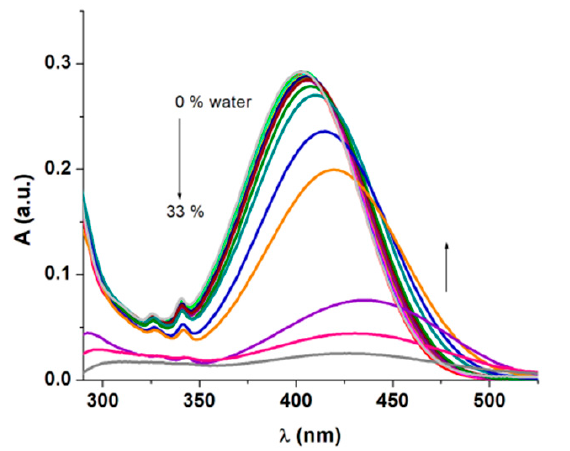
Figure 7. Changes in the electronic absorption spectra of 8 in dioxane solution as a function of water level.